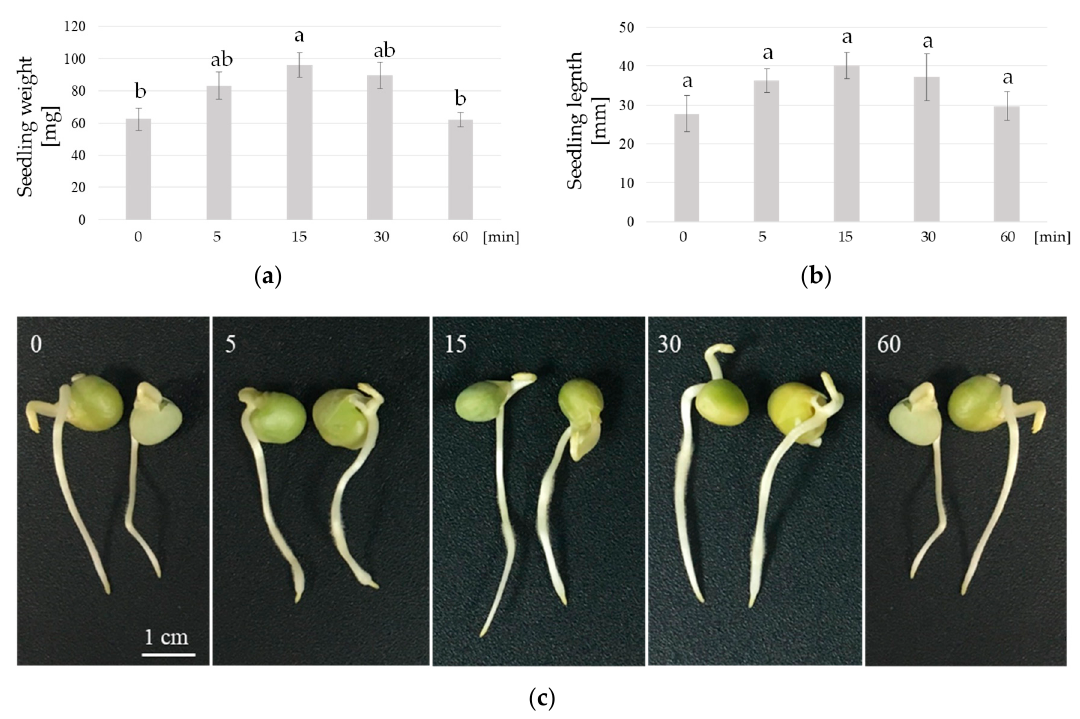
Figure 4. Effect of red light exposure (100 µmol m − 2 s − 1 ) (0–60 min) of pea seeds on the fresh weight ( a ), length ( b ) and overall appearance ( c ) of 3-day-old seedlings. Data represent the mean ± SE from 45 measurements. Different letters indicate significant differences according to Tukey ′ s test ( p ≤ 0.05).